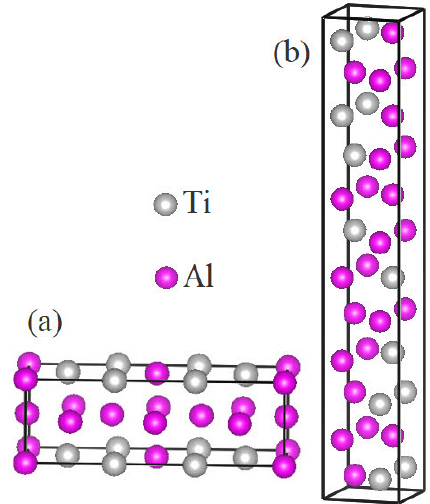
Figure 1. The unit cells of ( a ) h-Al 2 Ti and ( b ) r-Al 2